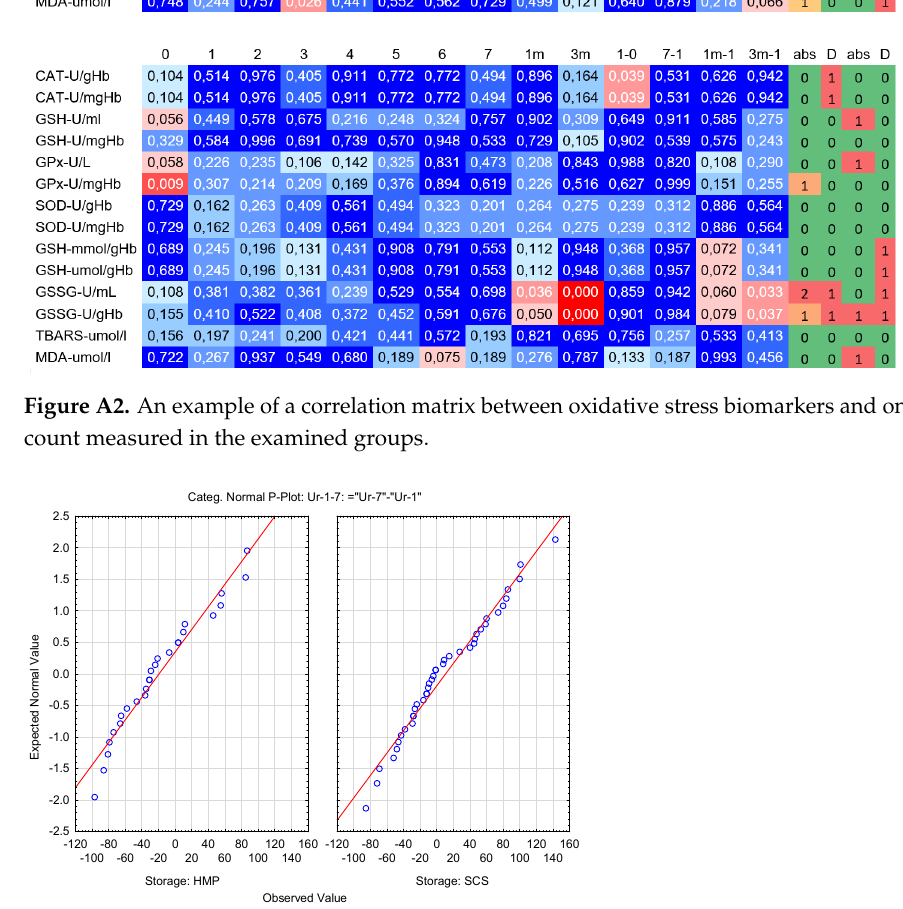
Figure A3. Categorized normal plot for relative urea concentration changes (∆) (ad Figure 8f).